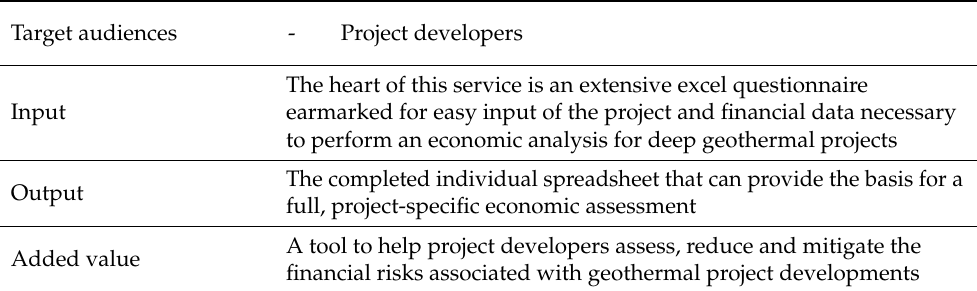
Table 7. Toolbox for risk evaluation and